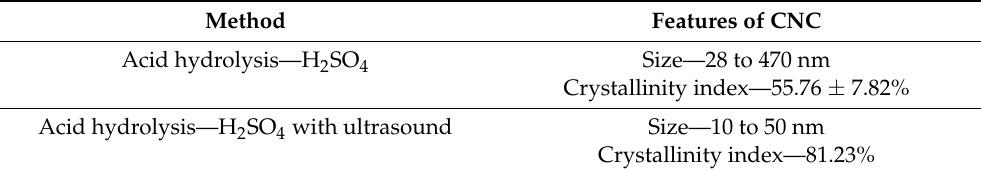
Table 3. Characteristics of CNCs obtained via acid hydrolysis with and without ultrasounds (adapted from